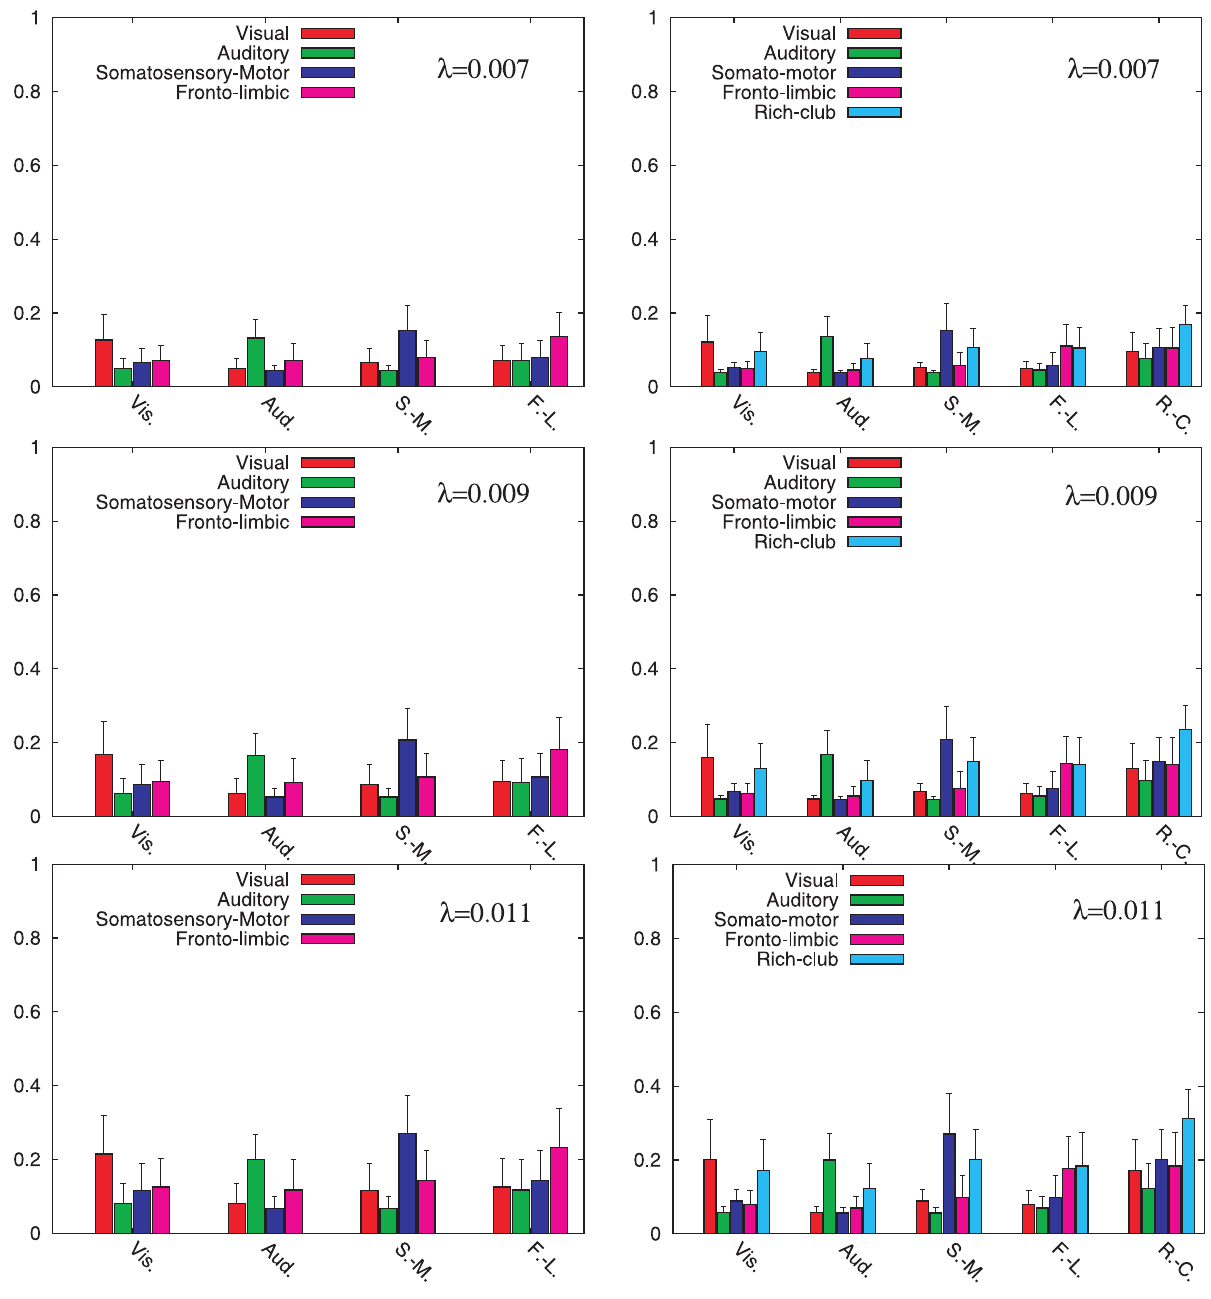
Figure 3. Dynamical correlation within the 4 modal clusters (left column) and the new 4 modally-related clusters and the Rich-Club (right column) before the onset of synchronization. The bars of the histograms show the values of the dynamical correlation r ab (see Equation (2)) between the 4 original modules (left) and the new 4 clusters and the Rich-Club (right). From top to bottom we show the cases for l ~ 0 : 007 , 0 : 009 and 0 : 011 that correspond to the region before the onset of synchronization.